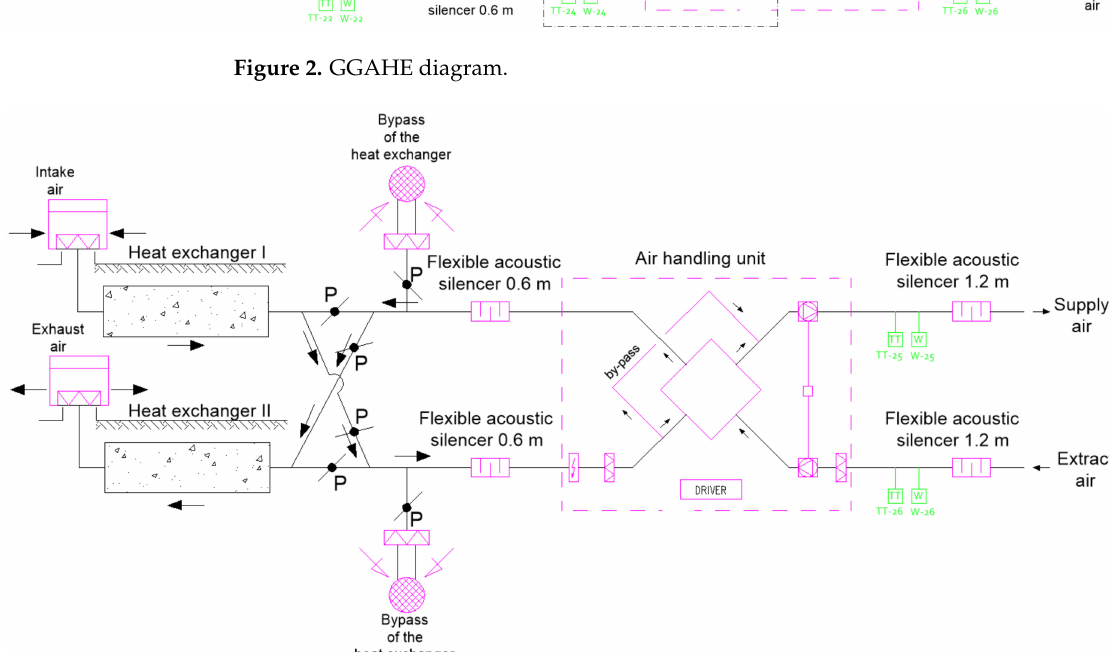
Figure 3. GGAHE diagram (based on